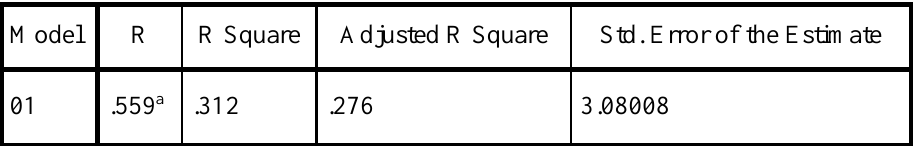
Table 02: Model Summary